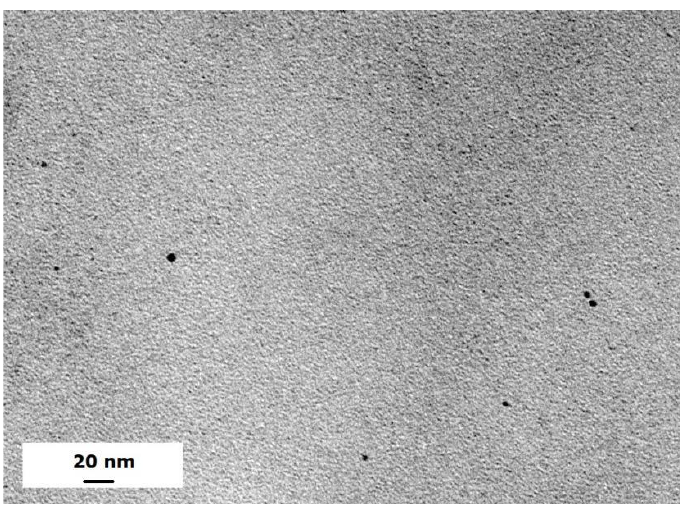
Figure 1. TEM image of metal particles with Ni/Pd = 20/1 at a scale bar of 20 nm.